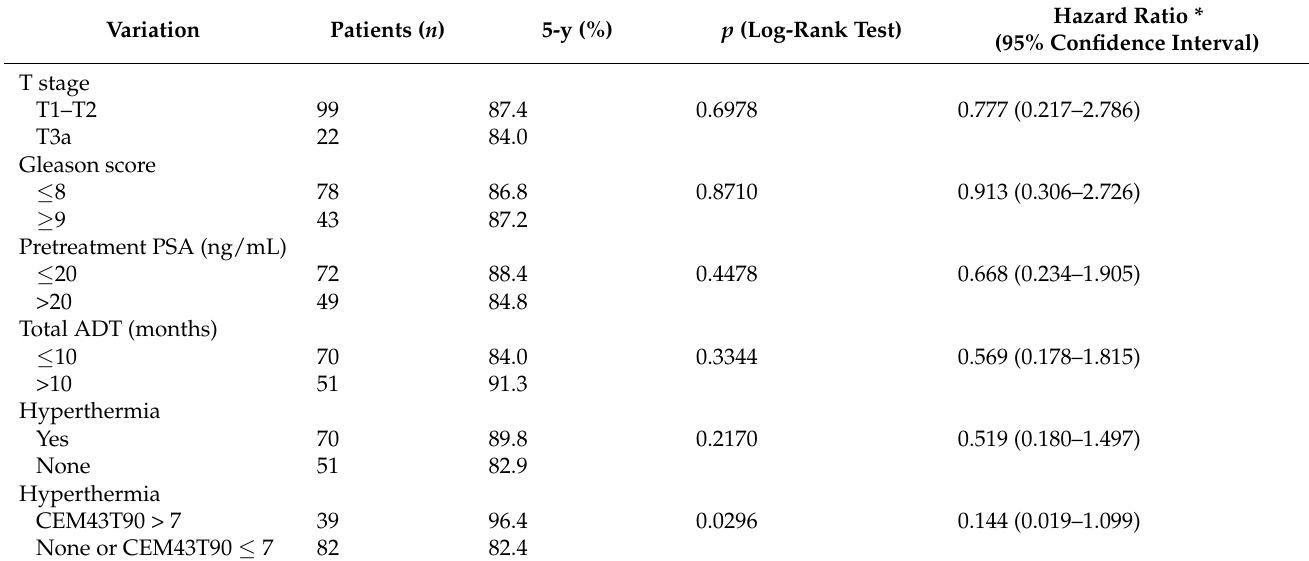
Table 2. Univariate analyses of certain factors for bDFS in 121 patients treated with IMRT with or without regional hyperthermia.